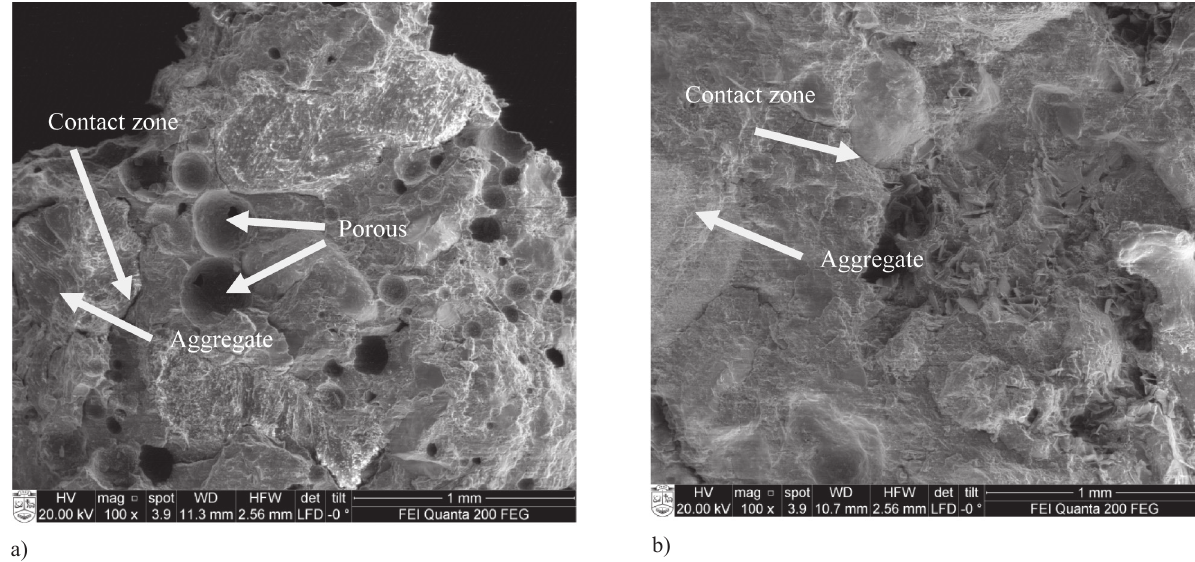
b)a) Fig. 9. SEM images of concrete microstructure with 10% of ECW after 28 days: conventional concrete (a) and polymer modified concrete (b)